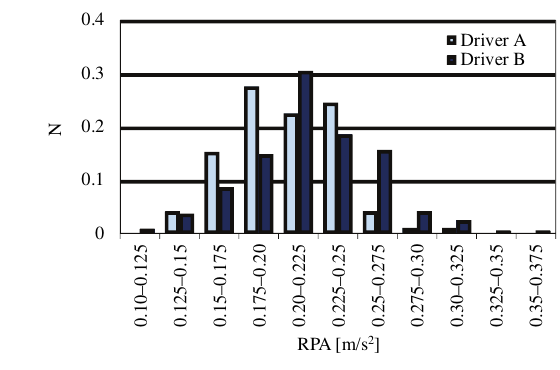
Fig. 20. Relative positive acceleration of the vehicle in urban driving conditions